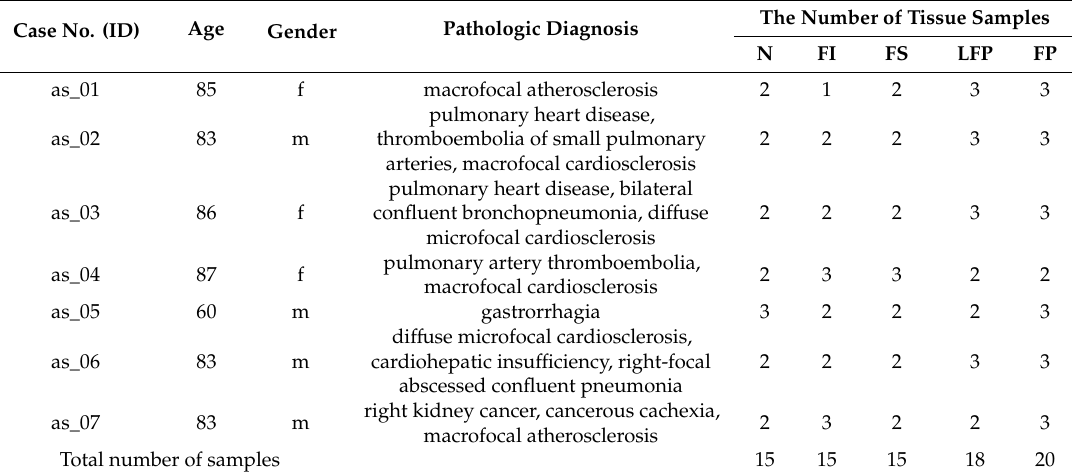
Table 1. Pathologic characteristics of aortic intima autopsy